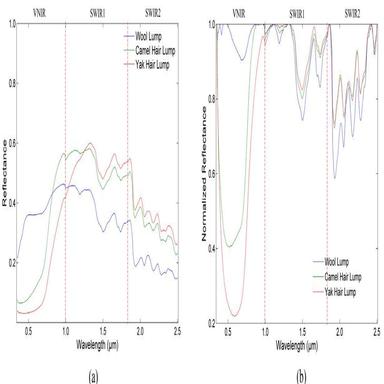
Spectral comparison between textile samples of animal hair, (a: reflectance spectra; b: CR spectra).